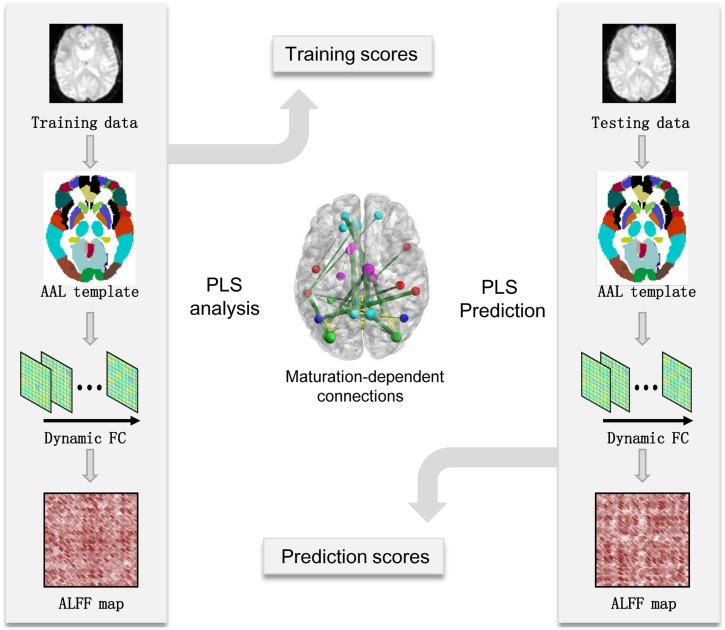
Flowchart of maturity prediction using the dynamics of resting-state functional connectivity. AAL, automated anatomical labeling; ALFF-FC, amplitude of low-frequency fluctuation of functional connectivity; FC, functional connectivity; PLS, partial least-squares.